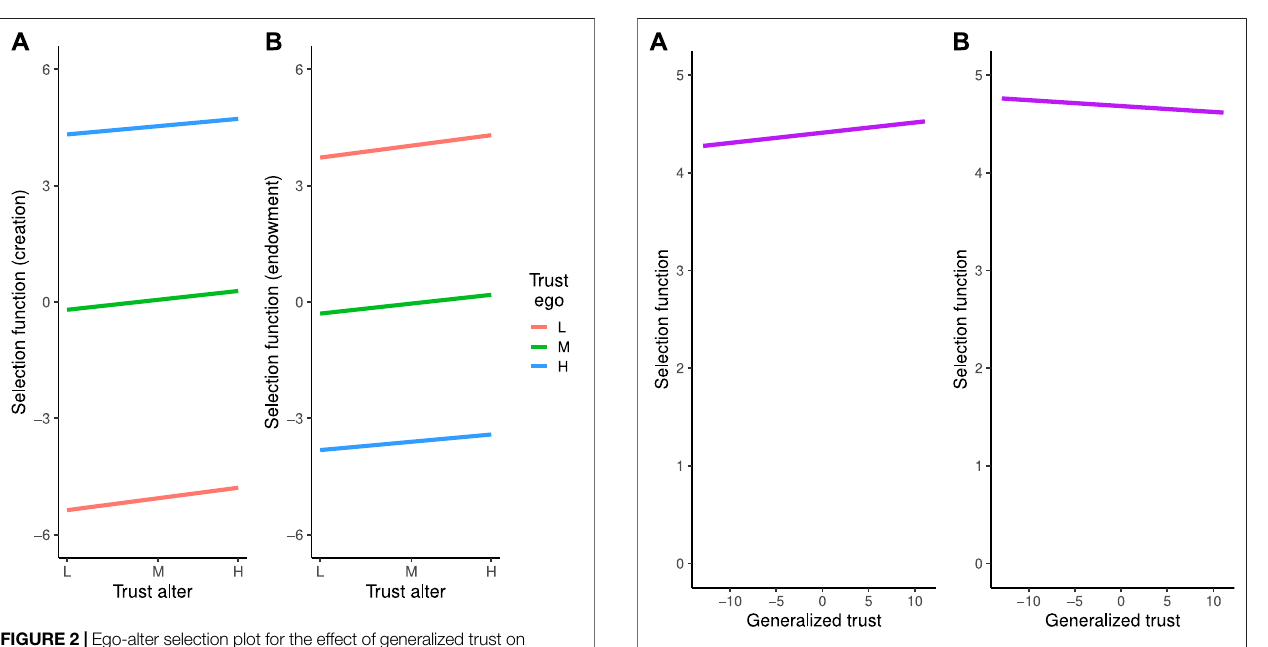
FIGURE3| Linearcombinationplotsoftheeffectofgeneralizedtrustonthe formation of transitive closure for advice seeking for the model in Table 2 (includingreciprocity,GWESPclosure,GWESPclosure × reciprocity,Trustego × GWESPclosure). (A) Thedegreeoflocalclustering(thenumberofoutgoing two-path) (cid:1) 3. (B) The degree of local clustering (cid:1) 8. GWESP (cid:1) geometrically weighted edgewise shared partners. α (cid:1) 0.69 in GWESP closure